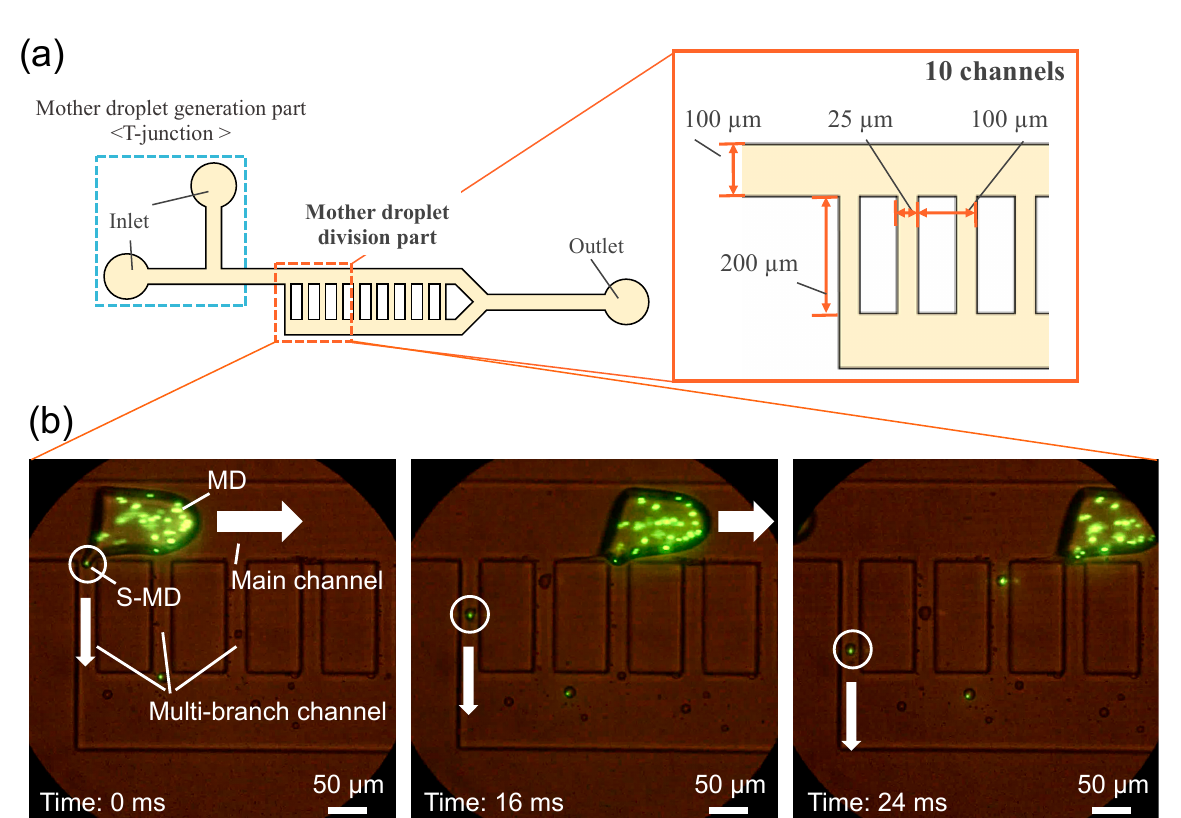
Figure 1. ( a ): Dimensions of device for generating microdroplets using tail breakup. ( b ): Inclusion of fluorescent microbeads. Microbeads in MoDs are successively encapsulated in S-MDs.